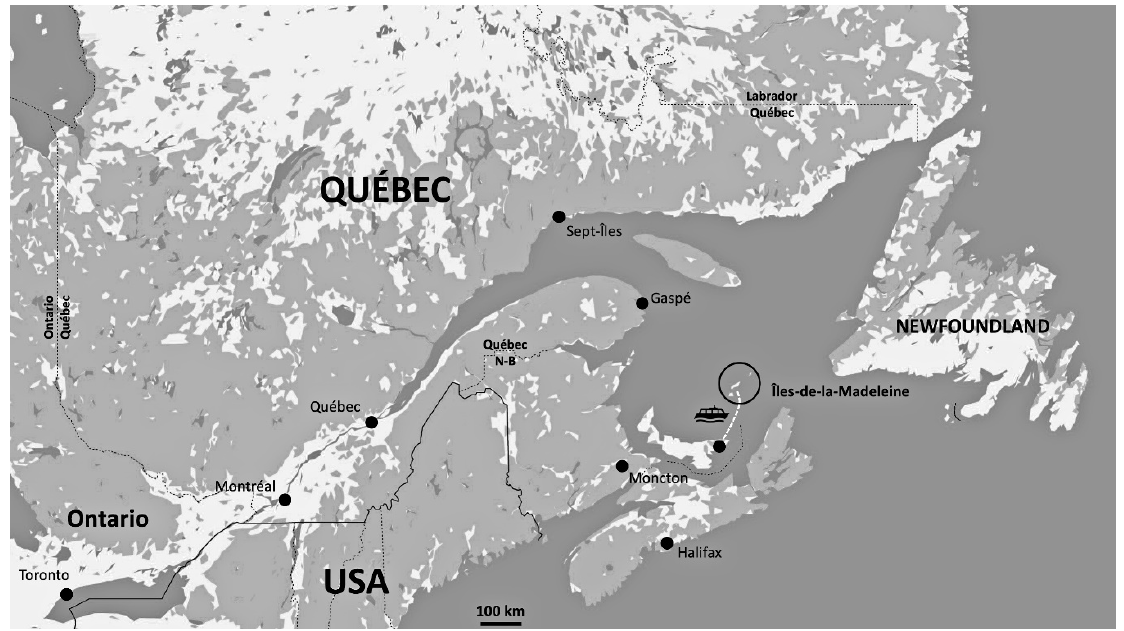
Figure 1. Localization of Iles-de-la-Madeleine (Magdalen’s Islands).